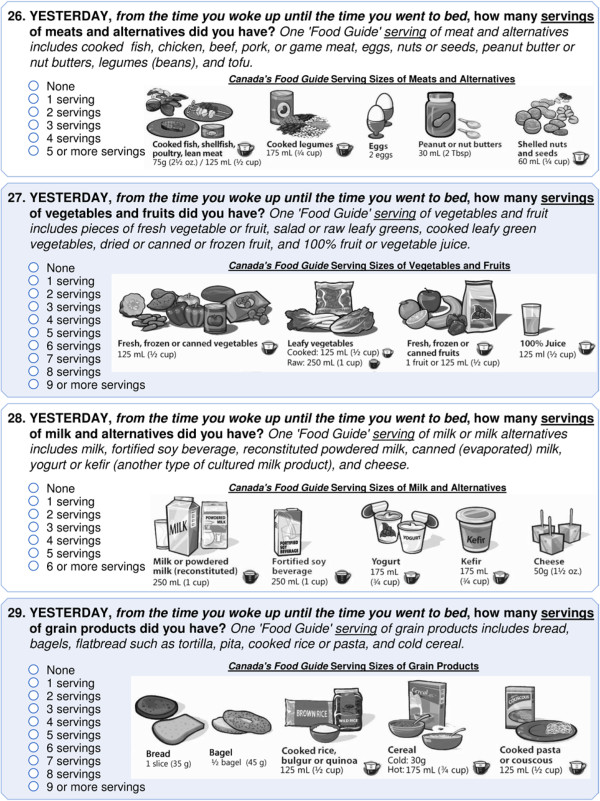
COMPASS questionnaire eating behaviour measures. Images from Canada’s Food Guide. Health Canada, 2011. Reproduced with the permission of the Minister of Health, 2011.